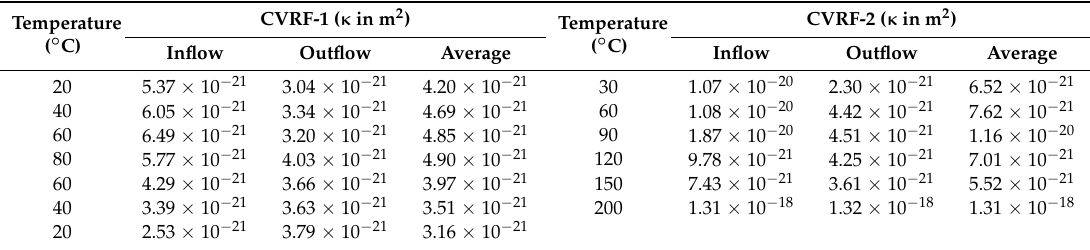
Table 4. Temperature and permeability data from CVRF-1 and CVRF-2